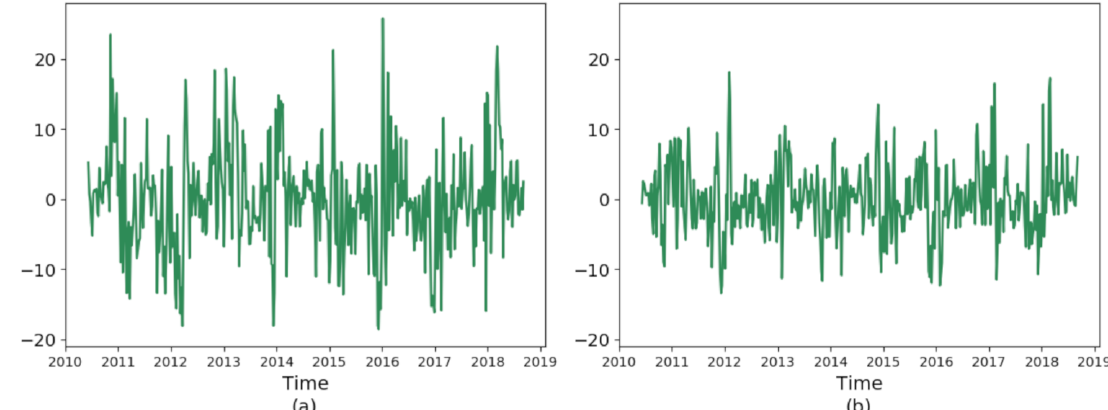
Figure 5. First ( a ) and second ( b ) time component of the weekly SP residuals.